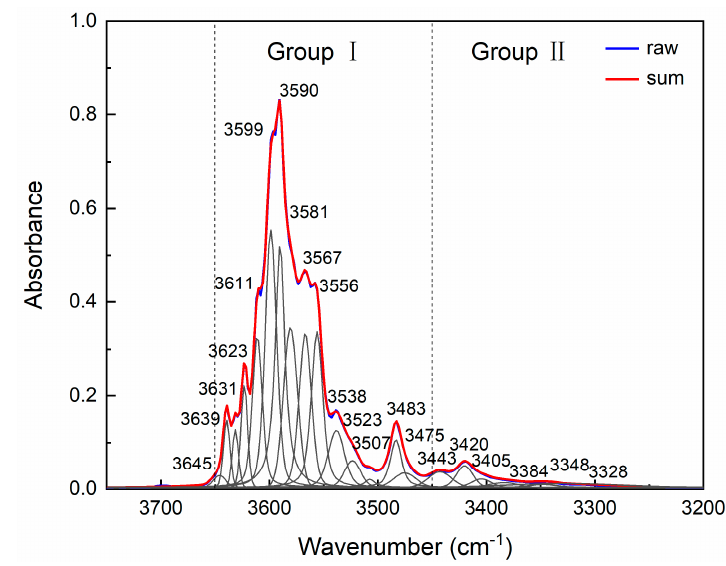
Figure 12. Gaussian–Lorentzian deconvolution of the OH infrared peaks of the forsterite in jianite (the 3750–3200 cm − 1 region). We used the PeakFit V4.12 software (SPSS Inc.) to process the IR data. The detected 21 Gaussian–Lorentzian peaks (the black curves) can be roughly divided into two groups, Group I in the range of ~3650–3450 cm − 1 and Group II in the range of ~3450–3200 cm − 1 . The sum (the red curve) of the 21 component peaks agrees well with the raw data (the blue curve) for the most data range.